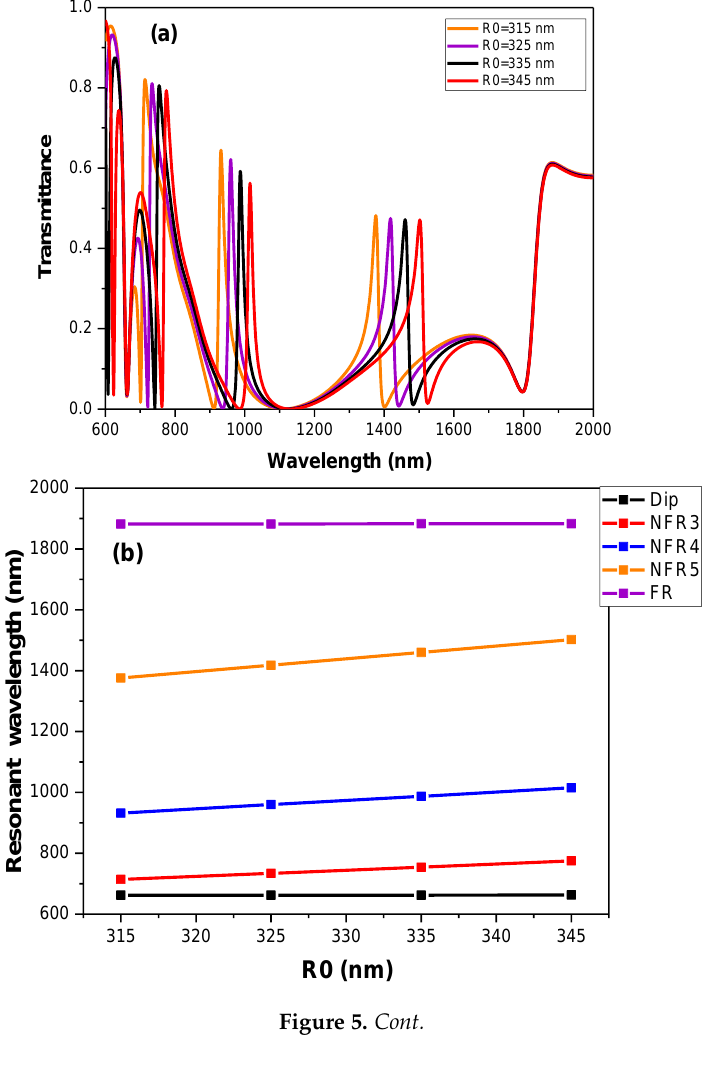
Figure 5. Content. Figure 5.